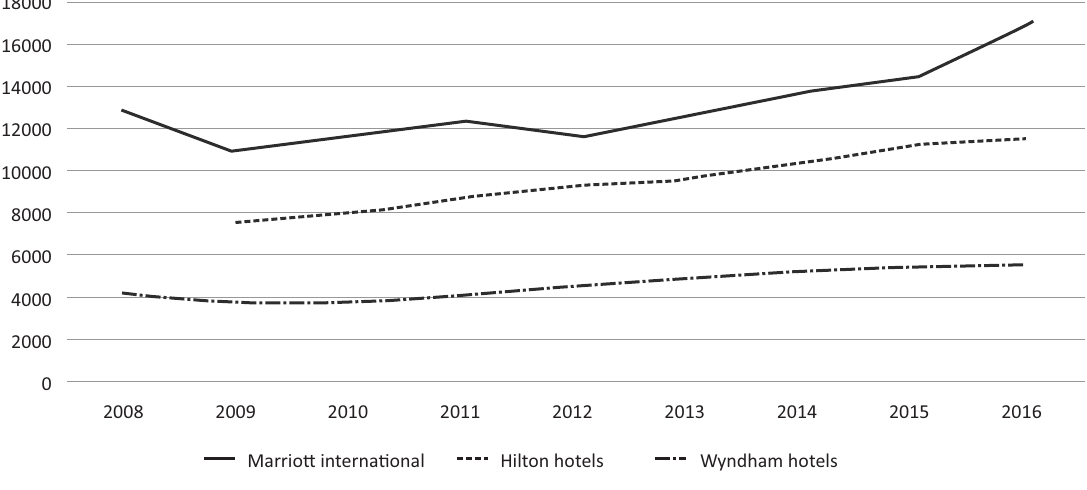
Figure 1. Dynamics of hotel chains’ total income, USD